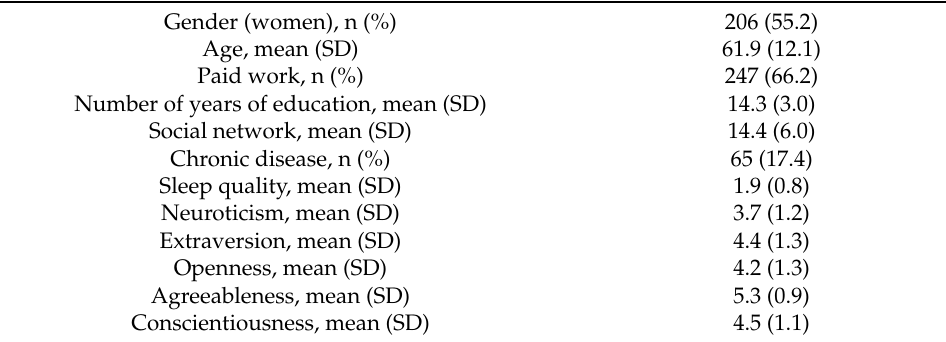
Table 1. Characteristics of participants (N = 373).